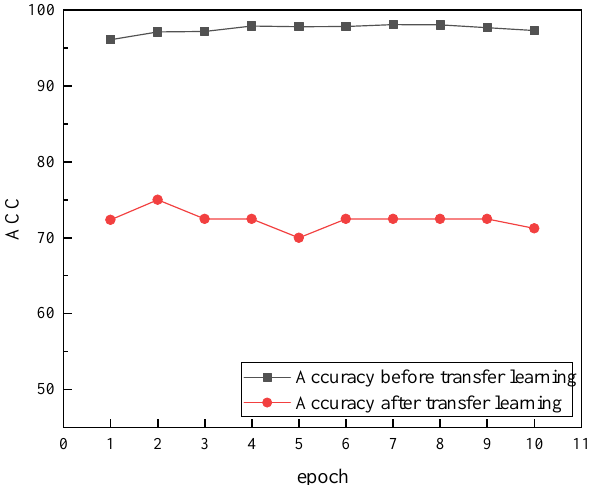
Figure 14. Comparison of accuracy before and after LeNet5 transfer learning.